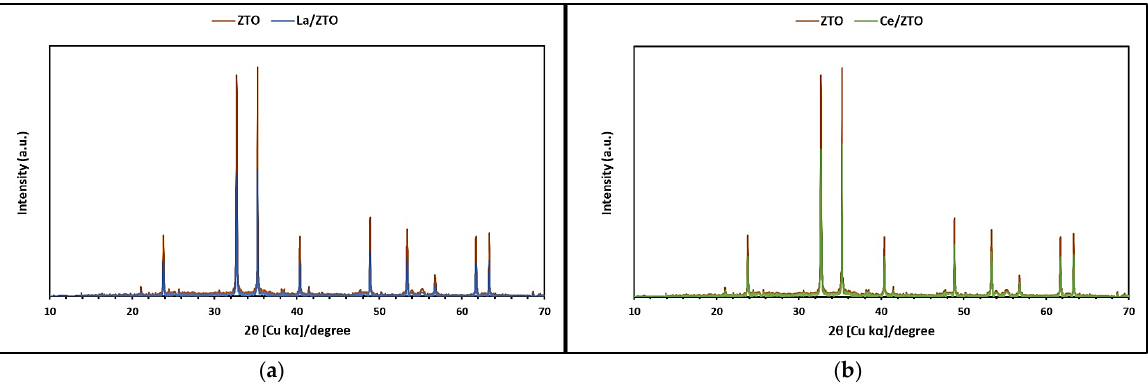
Figure 1. X-ray diffraction (XRD) pattern of the nanoparticles: ( a ) La/ZTO and ( b ) Ce/ZTO compared with ZTO. with